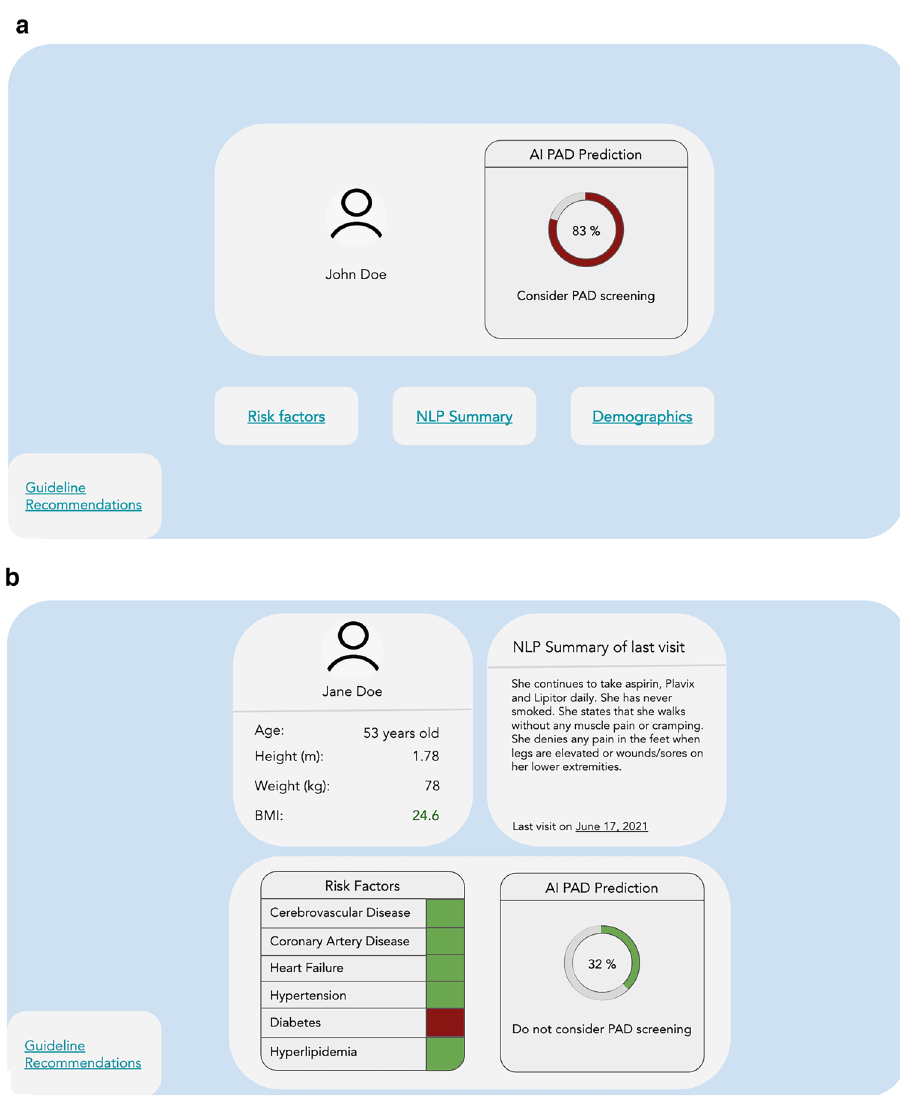
available only through directly clicking labeled links. ( b ) Unified Dashboard. All patient information is displayed in one frame of reference with guideline recommendations made available through clicking a link. AI—artificial intelligence; NLP—natural language processing; PAD—peripheral artery